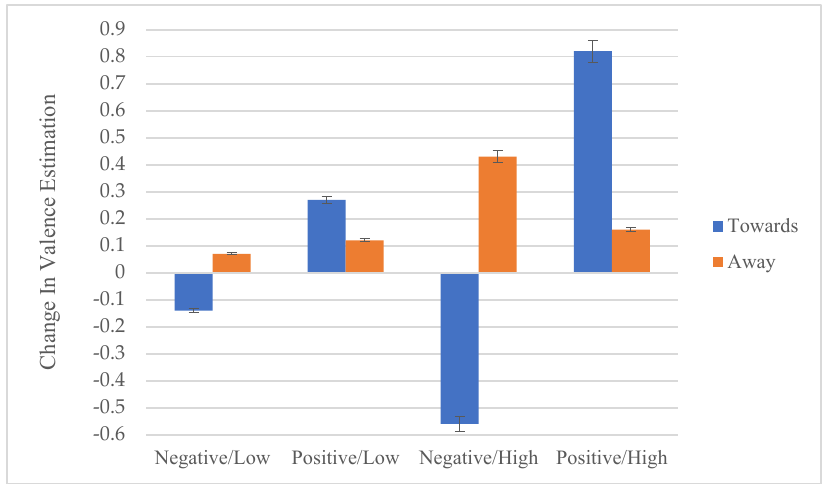
Figure 3. Change in valence estimations of emotional pictures (i.e., valence estimations post-interaction minus baseline estimations). Vertical bars indicate 95% confidence intervals adjusted for baseline.